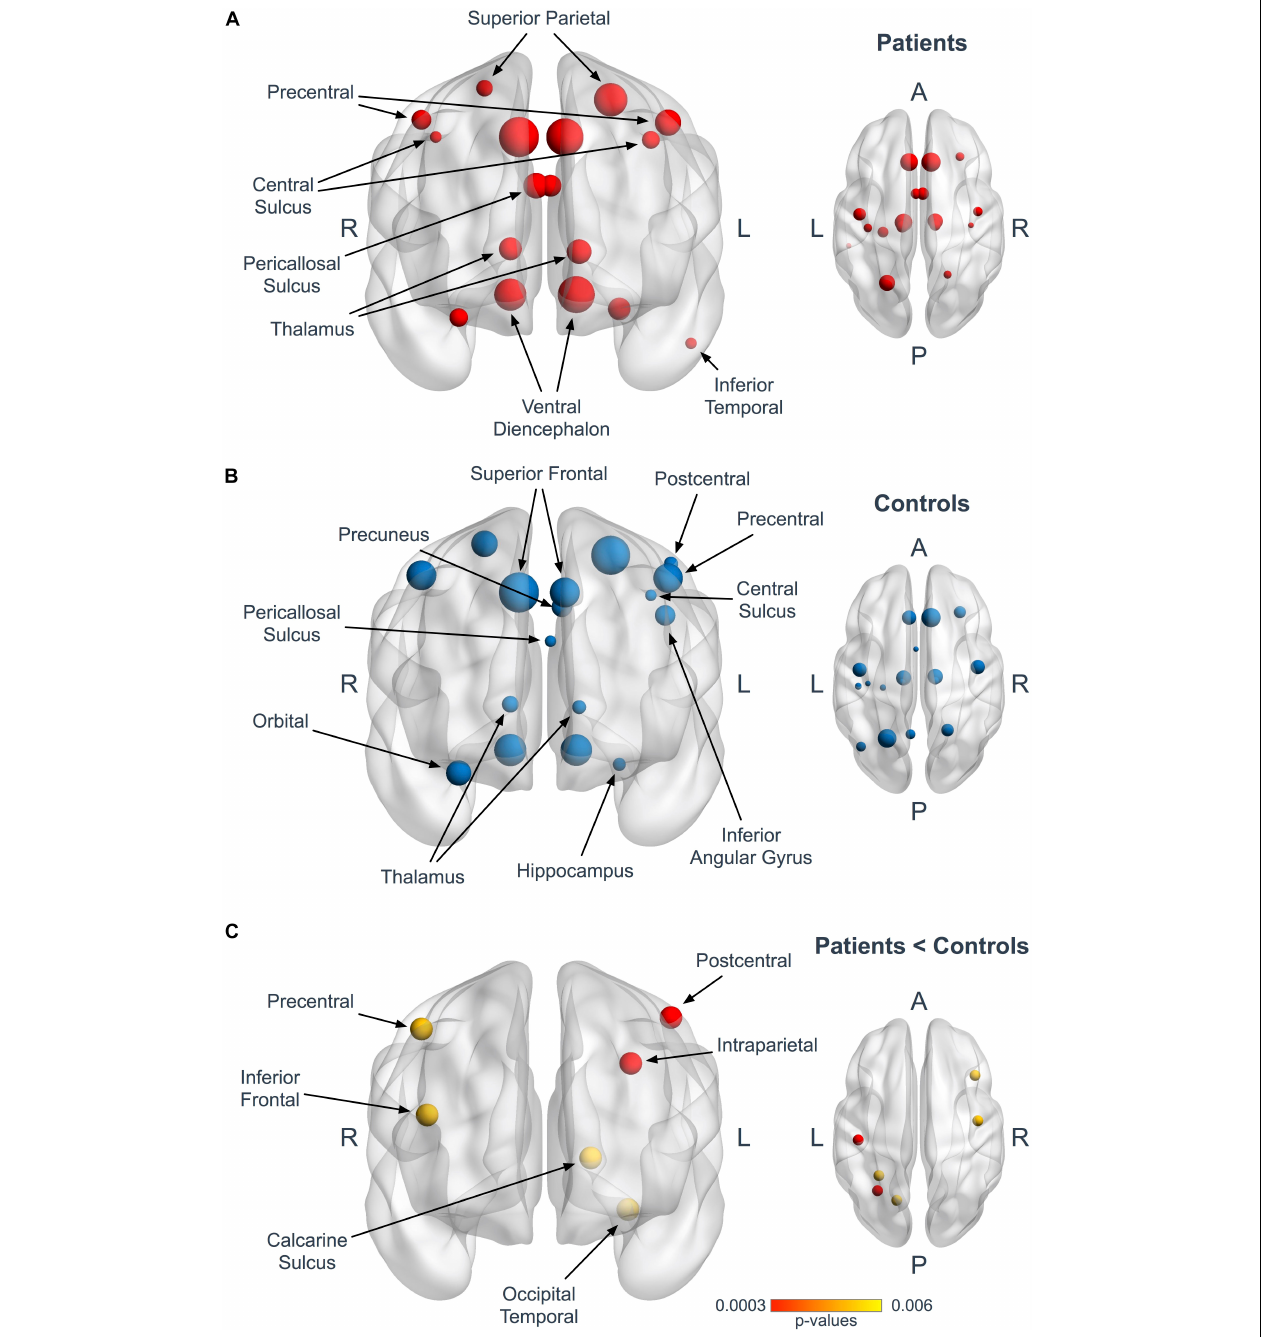
FIGURE 2 | Hubs in ALS patients and controls. Panels (A,B) represent coronal and axial views illustrating the hubs in patients ( A , red) and controls ( B , blue). The size of the nodes is proportional to their degree values. Panel (C) shows the 6 nodes with significantly reduced mean degree in patients at the Bonferroni corrected threshold (red, p < 0.0003) and at the 1/n exploratory threshold (yellow, p <